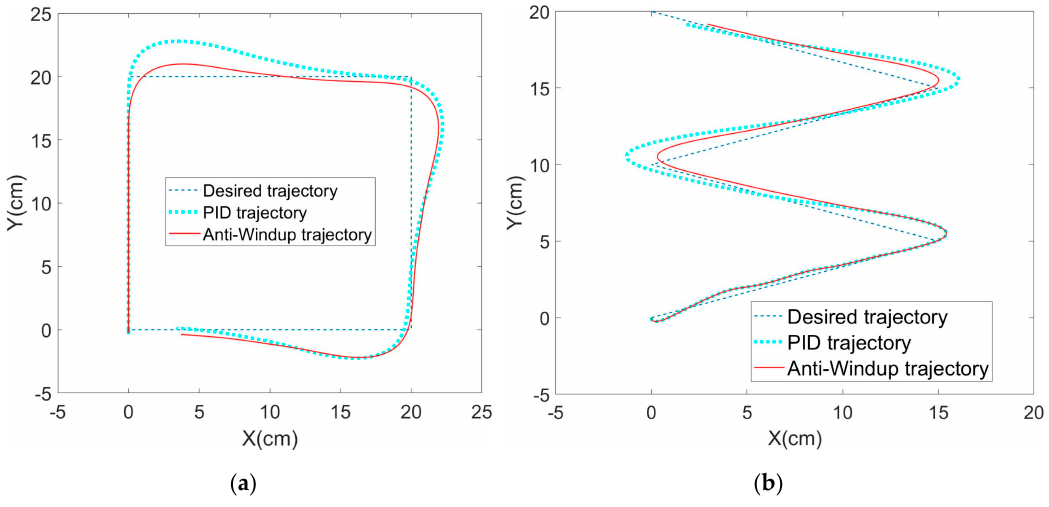
Figure 24. Simulation test of PTZ controller trajectory tracking: ( a ) shape of square; ( b ) shape of Z.